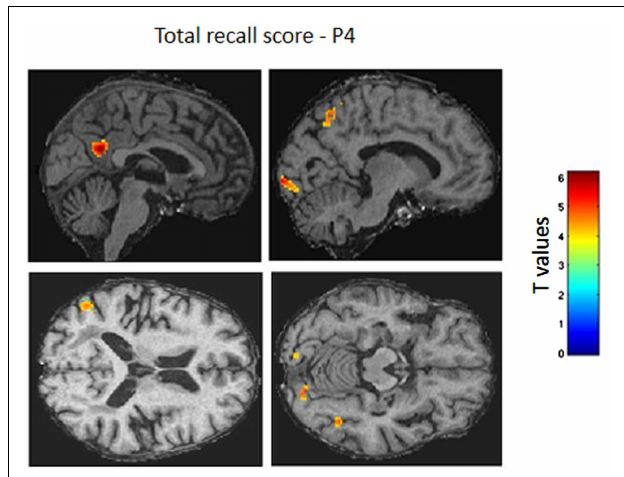
FIGURE 5 | Correlations between resting-state brain glucose consumption and autobiographical memory for recent events . Positive correlations are shown as colored voxels superimposed on sagittal sections of an individual AD patient’s MRI normalized on the Montreal Neurological Institute (MNI) template ( p < 0.001, uncorrected).The two sagittal sections (top) depict correlation with metabolism of the precuneus, calcarine region, and angular gyrus.The two axial sections (bottom) illustrate correlations with middle temporal